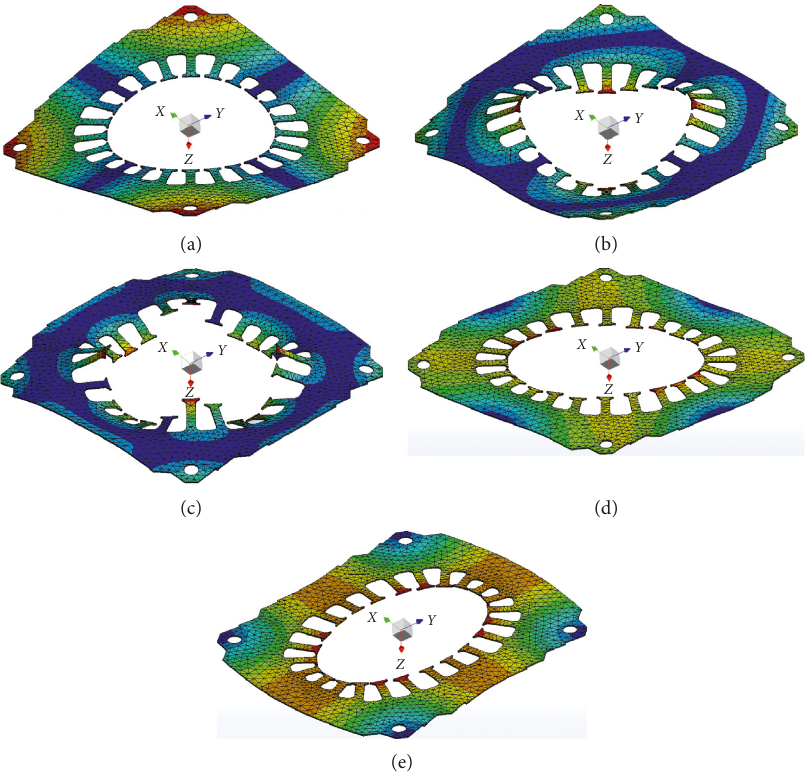
Figure 12: Numerical modal shapes of the laminated disk, whose characteristics are repeated on the stator laminated disks pack, according to experimental modal analysis: (a) ω N : 116.8Hz; (b) ω N : 773.6Hz; (c) ω N : 1509.3Hz; (d) ω N : 3769.8Hz; (e) ω N : 3986.2Hz.